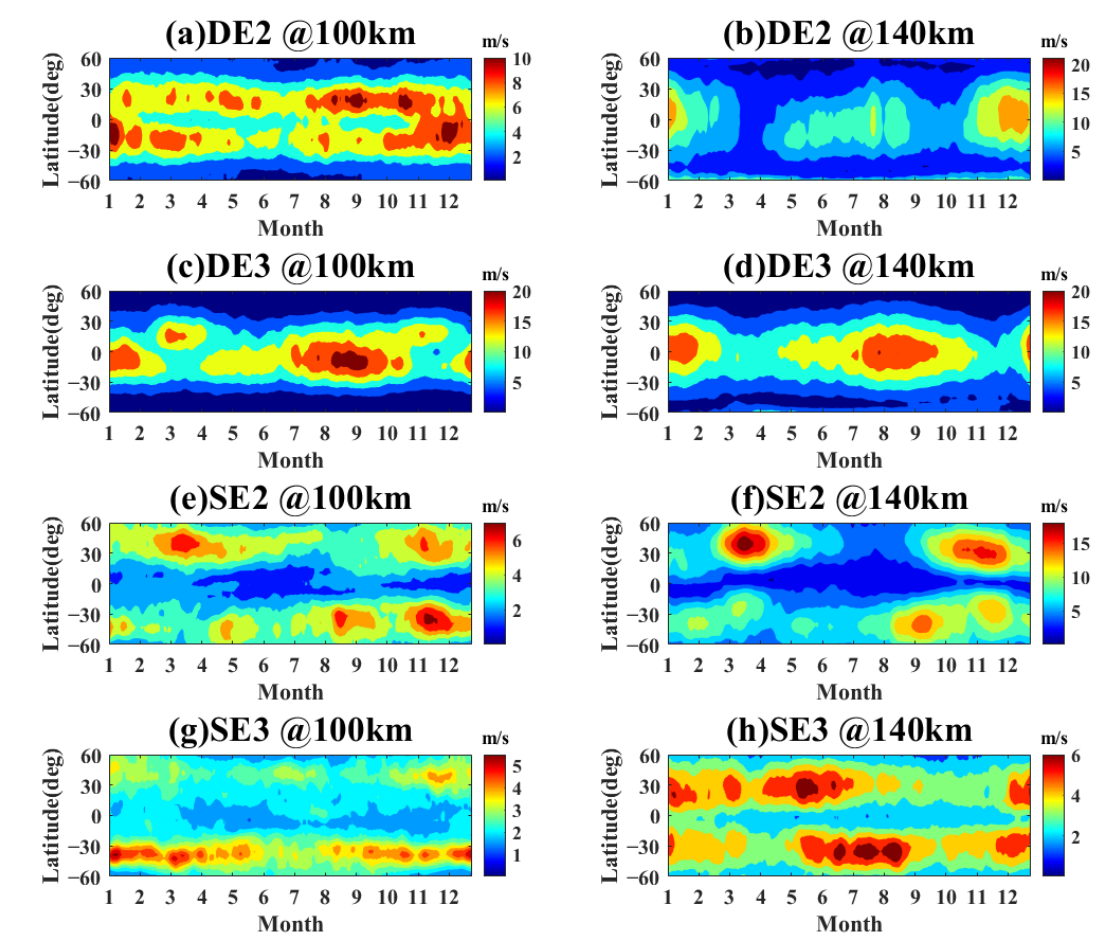
Figure 6. Seasonal variations in non-migrating tides ( a , b ) DE2, ( c , d ) DE3, and ( e , f ) SW2, ( g , h ) SE3 at ( a , c , e , g ) 100 km, and ( b , d , f , h ) 140 km between 60 ° S and 60 ° N from 2003 to 2019.